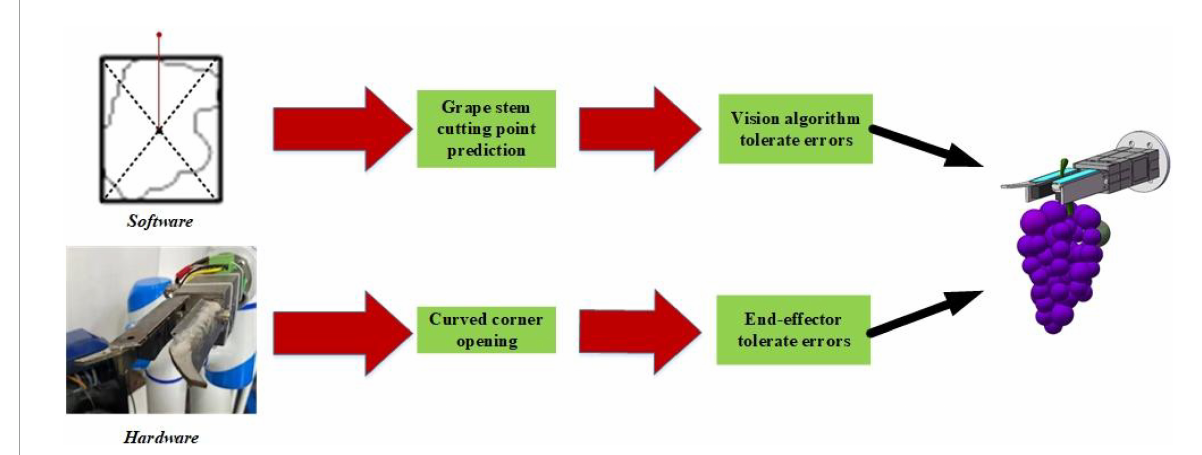
FIGURE11 Error tolerance combinations of the end effector and vision algorithms.